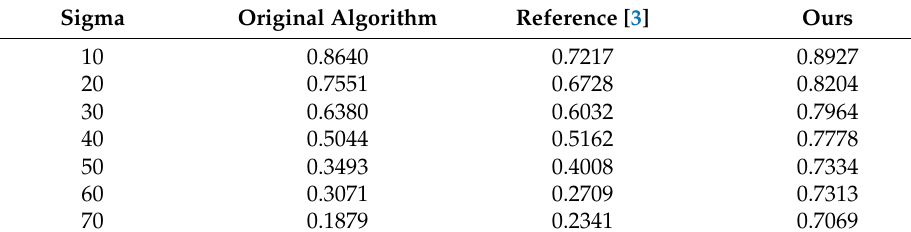
Table 6. SSIM of the three algorithms for the Monarch image.